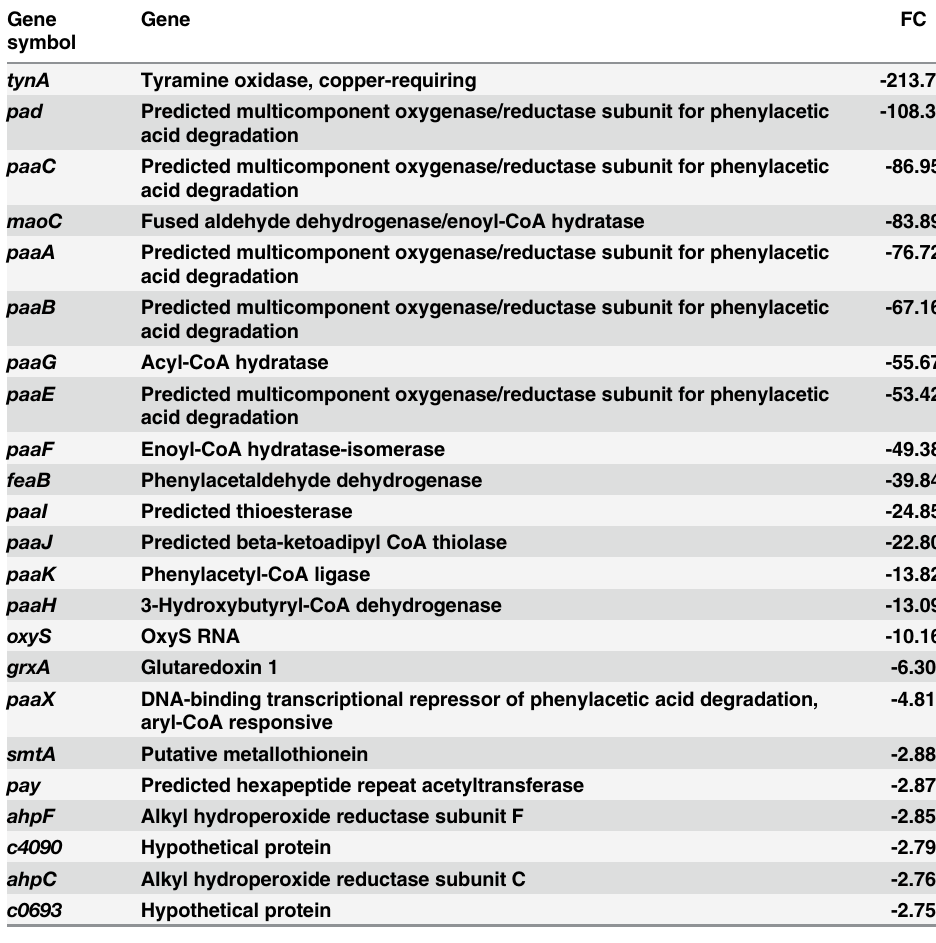
Table 3. Differentially down-regulated (FC < -2.50) genes in Δ tynA . a